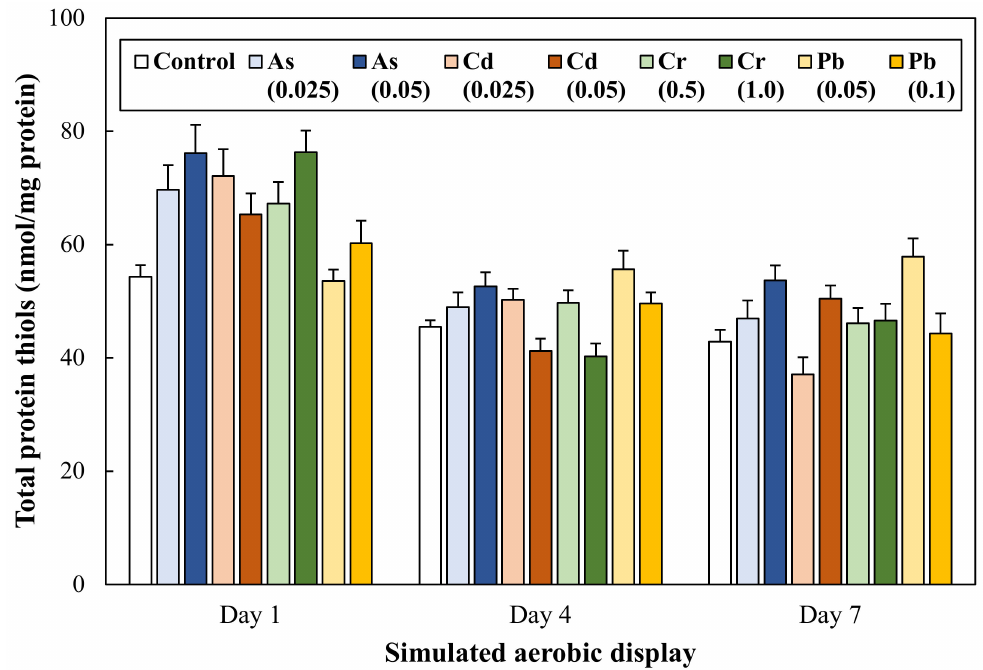
Figure 5. Change in total protein thiol content of ground pork intentionally contaminated with toxic heavy metals during 7 days of aerobic display storage. The number in parentheses in legend indicates the target concentration (mg/kg) of each heavy metal in ground pork. Error bars represent each standard error